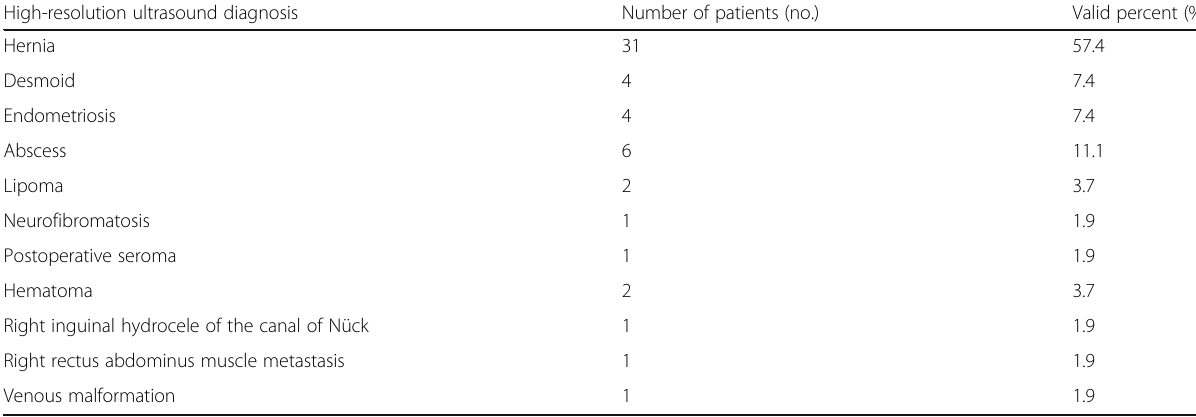
Table 3 The results by the high-resolution ultrasound examination with the demonstration of the number (no.) and the percent (%) of the affected patients High-resolution ultrasound diagnosis